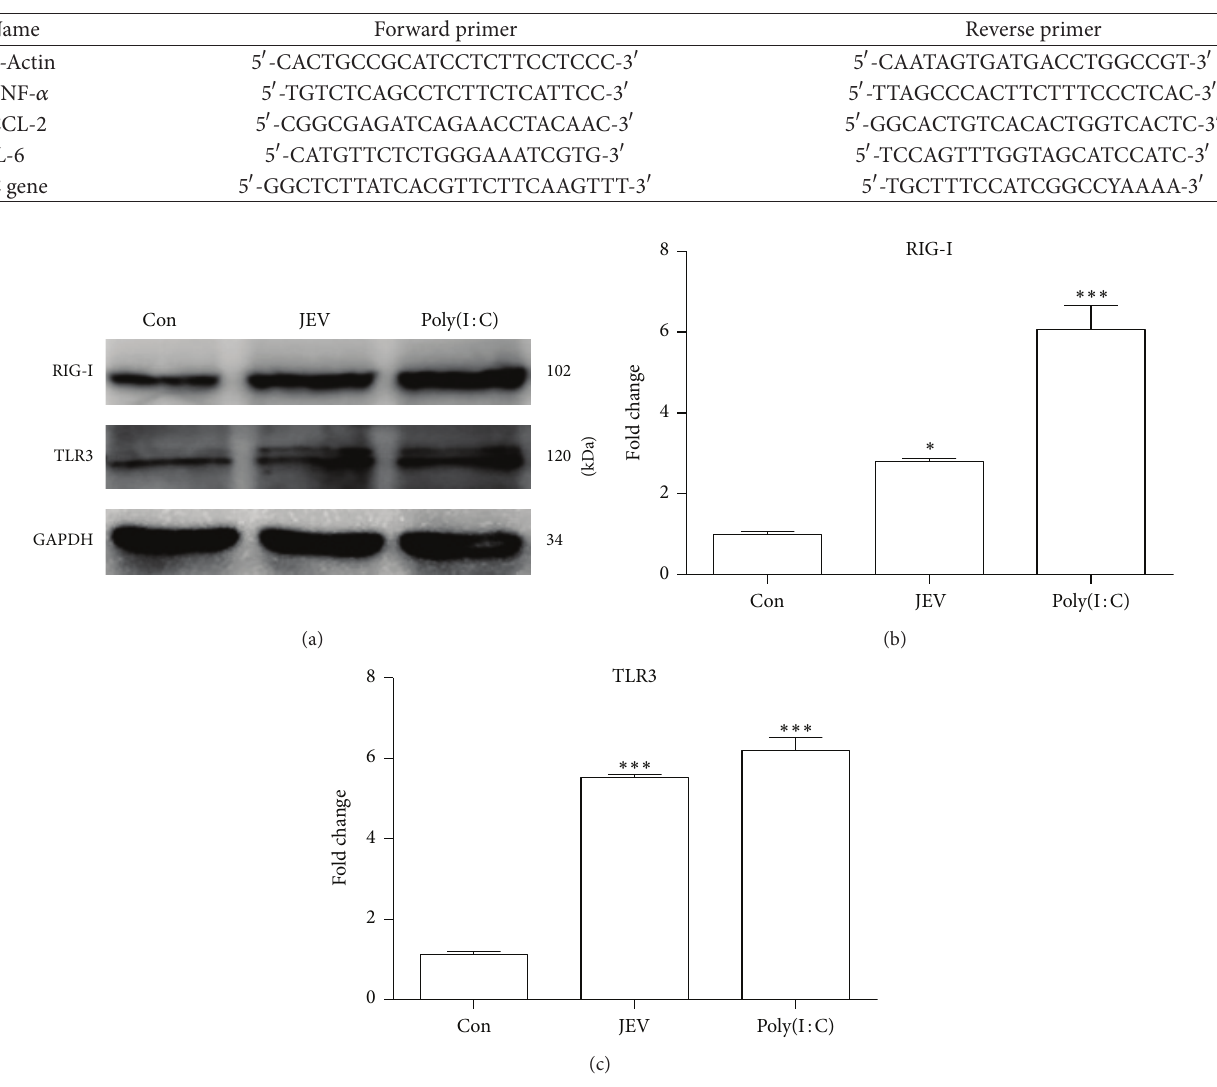
Figure 1: Expression of TLR3 and RIG-I in JEV-infected BV-2 cells. (a) BV-2 cells were either mock infected or infected with JEV at an MOI of 1. Poly(I: C) was added as a positive control. Western blotting was performed to detect TLR3 and RIG-I at 24 hpi. (b, c) The protein levels were quantified with immunoblot scanning and normalized to the amount of GAPDH. Error bars represent the standard deviation of results from three independent assays ( ∗ 𝑃 < 0.05 ; ∗∗∗ 𝑃 < 0.001